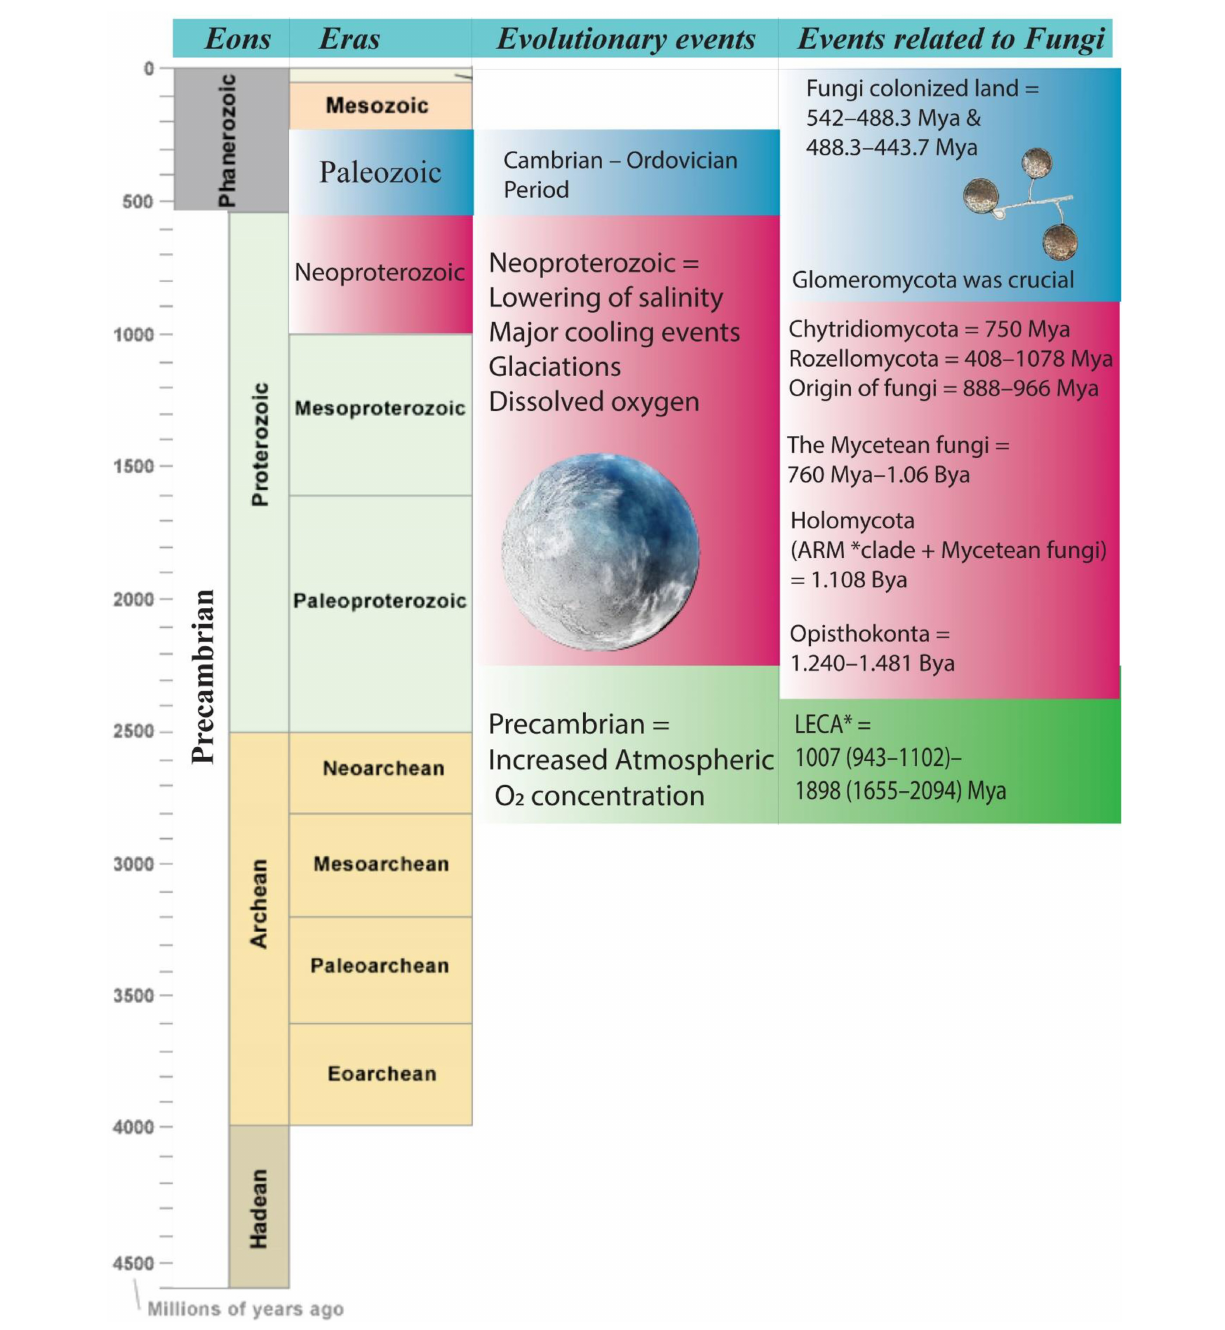
FIGURE 1 | Schematic representation of evolutionary timeline related to fungi. *ARM, Aphelidomycota, Rozella , Microsporidia ; *LECA, last eukaryotic common